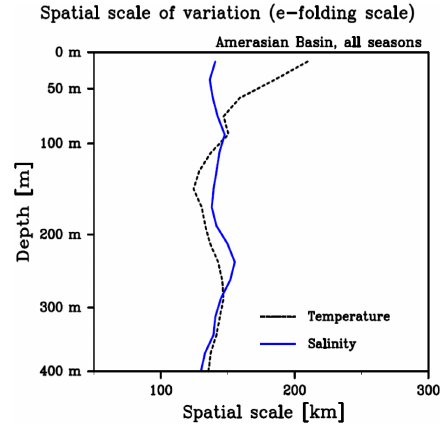
Figure 6. Vertical profile of spatial scale of variation ( e -folding scale of the normalized RMSD function, f ) derived from the fit- ted Gaussian function for each depth level (see also Fig. 5). The scale in each depth range is calculated from data from all